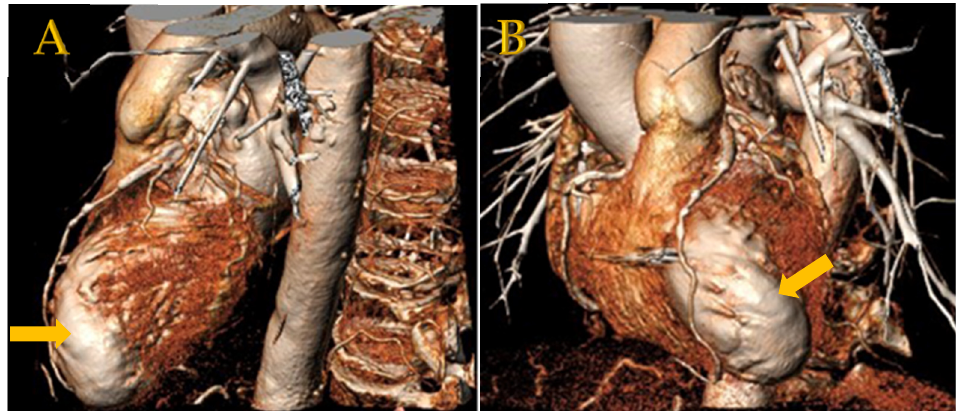
Figure 4. ( A , B ) Left anterior oblique (LAO) cranial coupes of CT-derived 3D reconstruction before LIVE procedure, made as part of procedural planning, revealing a prominent scarred aneurysm of the left ventricle (arrows).